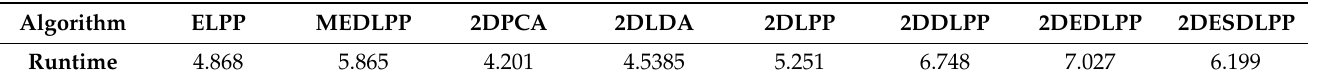
Table 7. The runtime (s) of eight different algorithms when the number of training samples in the AR database is